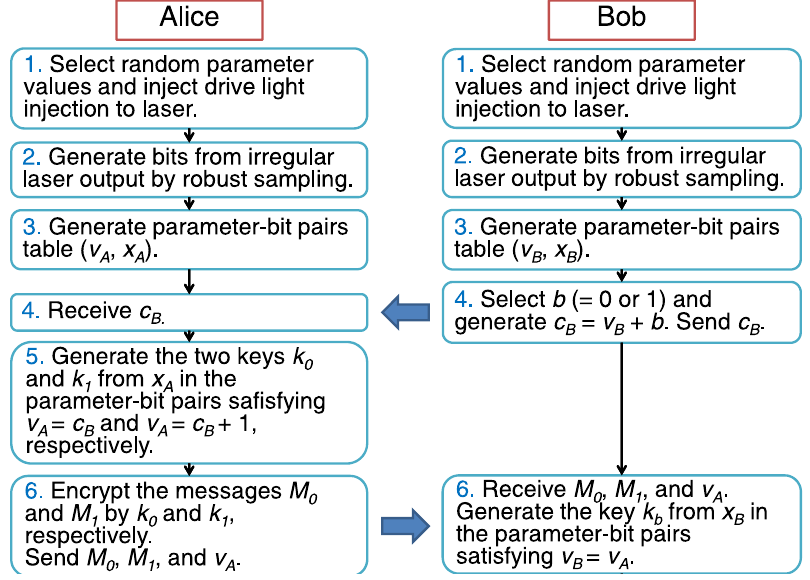
Figure 2. Protocol of one-out-of-two oblivious transfer. + Denotes bitwise exclusive-OR operation. ν Α , Β : random observation parameters for Alice and Bob. x A,B : observed bits for Alice and